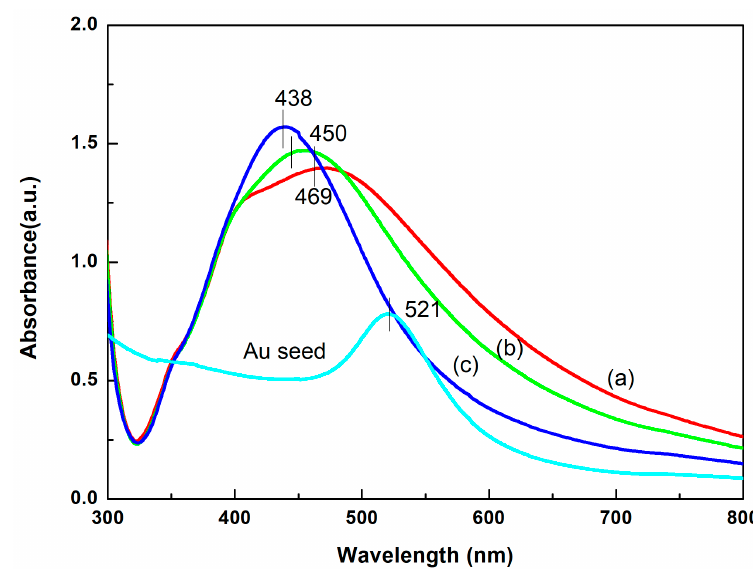
Figure 2. UV-vis spectra of colloidal Au seeds and Au@Ag NPs synthesized with various amounts of Au seeds including ( a ) 0.4 mL; ( b ) 0.5 mL; ( c ) 0.9 mL.